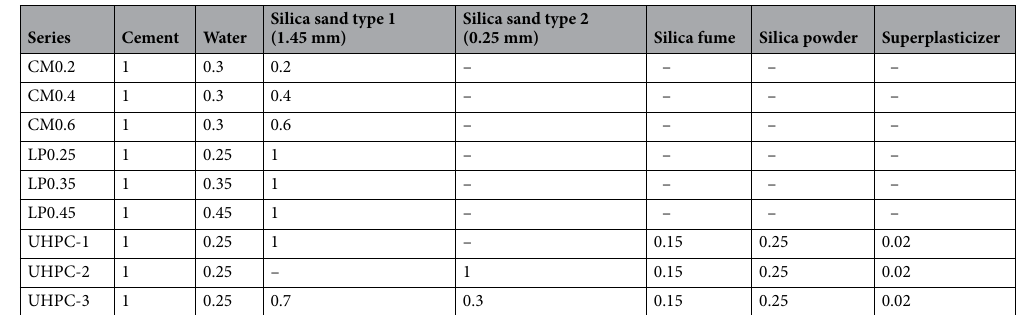
Table 1. Experimental samples mix design (Proportion by mass).